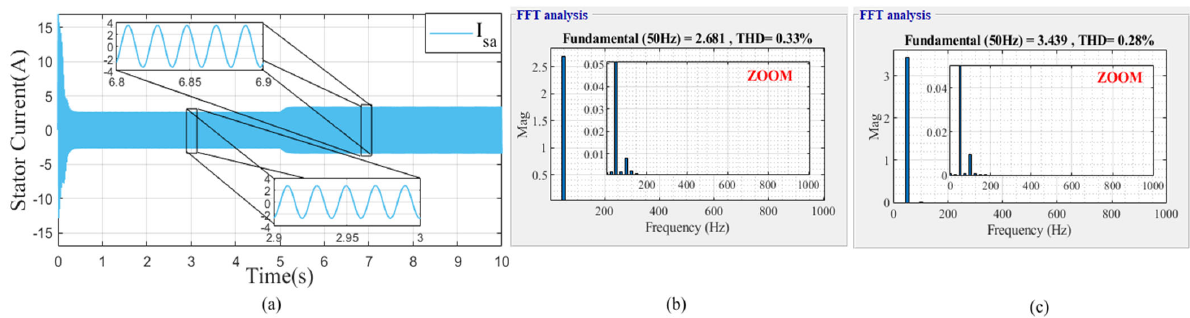
Figure 23. Performance with Cage bearing defect of IM without control: ( a ) Stator current and ( b ) THD at no ‐ load and ( c ) THD with load (5 Nm). Figures 14–18 illustrate the temporal signature of the mechanical quantities of torque and speed when the IM is powered directly by a fixed frequency source at 50 Hz for a healthy machine, and then in the presence of the four BDs. In the healthy state, the speeds, and frequencies of rotation unloaded are, respec ‐ tively, 1466.26 Rpm and 24.43 Hz. Under the load torque (T ref = 5 Nm) they become 1341.64 Rpm and 22.36 Hz. These values are the references that allow the determination of the characteristic frequencies in the case of BD. All electrical (current) and mechanical (torque and speed) signals are normal and have no ripples, so the THD in this case is zero. In the presence of BDs, Figures 14–18 clearly show the undulations of torque and speed, so the THD summarizes the influence of BDs on the current of the stator. Indeed, for the BD at the bearing cage, the ripples of the speed and electromagnetic torque have an amplitude of about 6 Rpm and 0.2 Nm, respectively, while for the other BDs (IR, OR, and Ball), the speed and torque are less wavy and do not exceed 2 Rpm and 0.05 Nm, respectively. In addition, Figures 19–23, show the THD of the current in the event of BD. The THD deflates the amplitude of the ripples of the quantities of torque and speed. That is why it is higher for the defect of the cage (0.97% in load and 0.93% empty), and it comes up to 0.11% in load and 0.12% unload for the defect of the inner ring of the bearing. Moreover, for the three BDs (IR, OR, and Ball), the THD of the current under load is slightly lower than that in the empty case. The difference can reach 0.05%, but when the ripples are sig ‐ nificant, as in the case of the cage defect, it becomes negative ( − 0.04%). Figure 24 illustrates the spectra in relation to the different BDs. For each defect, there are two spectra; the first on the left depends on the empty speed (1466.26 Rpm), and the second on the right depends on the speed under load (1341.64 Rpm). Thus, the variation Δ f of the frequency of the spectra depends on the type of BD. This variation is 11.2 Hz for the IR defect, which has the highest characteristic frequency (f IR = 5.43.fr) and for the cage defect, which has the smallest characteristic frequency (f Cage = 0.79.fr), the variation Δ f = 1.5 Hz. This is already confirmed in formulas 23 to 27, where the frequency content of BD is